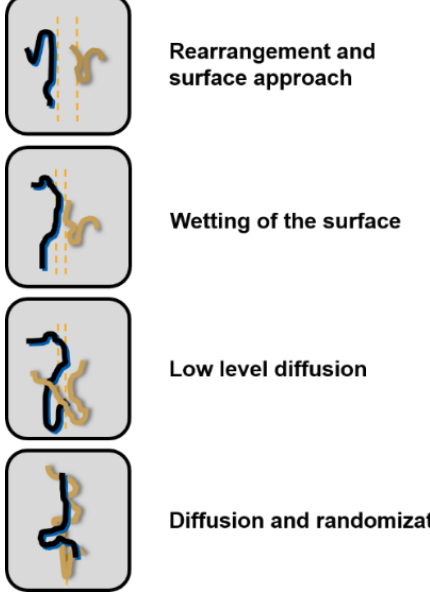
Figure 2. Basic molecular structure of PDMS.